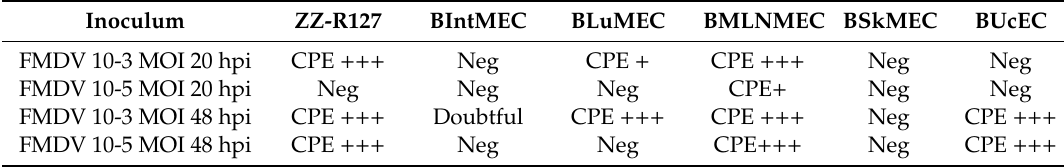
Table 4. Cytopathic effect (CPE) observed after FMDV inoculation of bovine endothelial cell lines. Inoculum